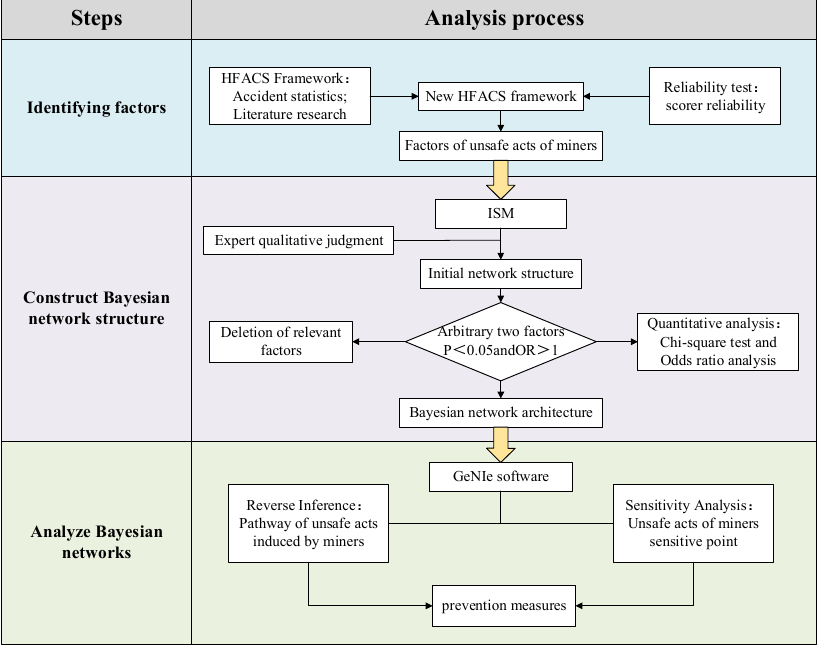
Figure 1. Unsafe acts risk analysis process of coal mine gas explosion accident.